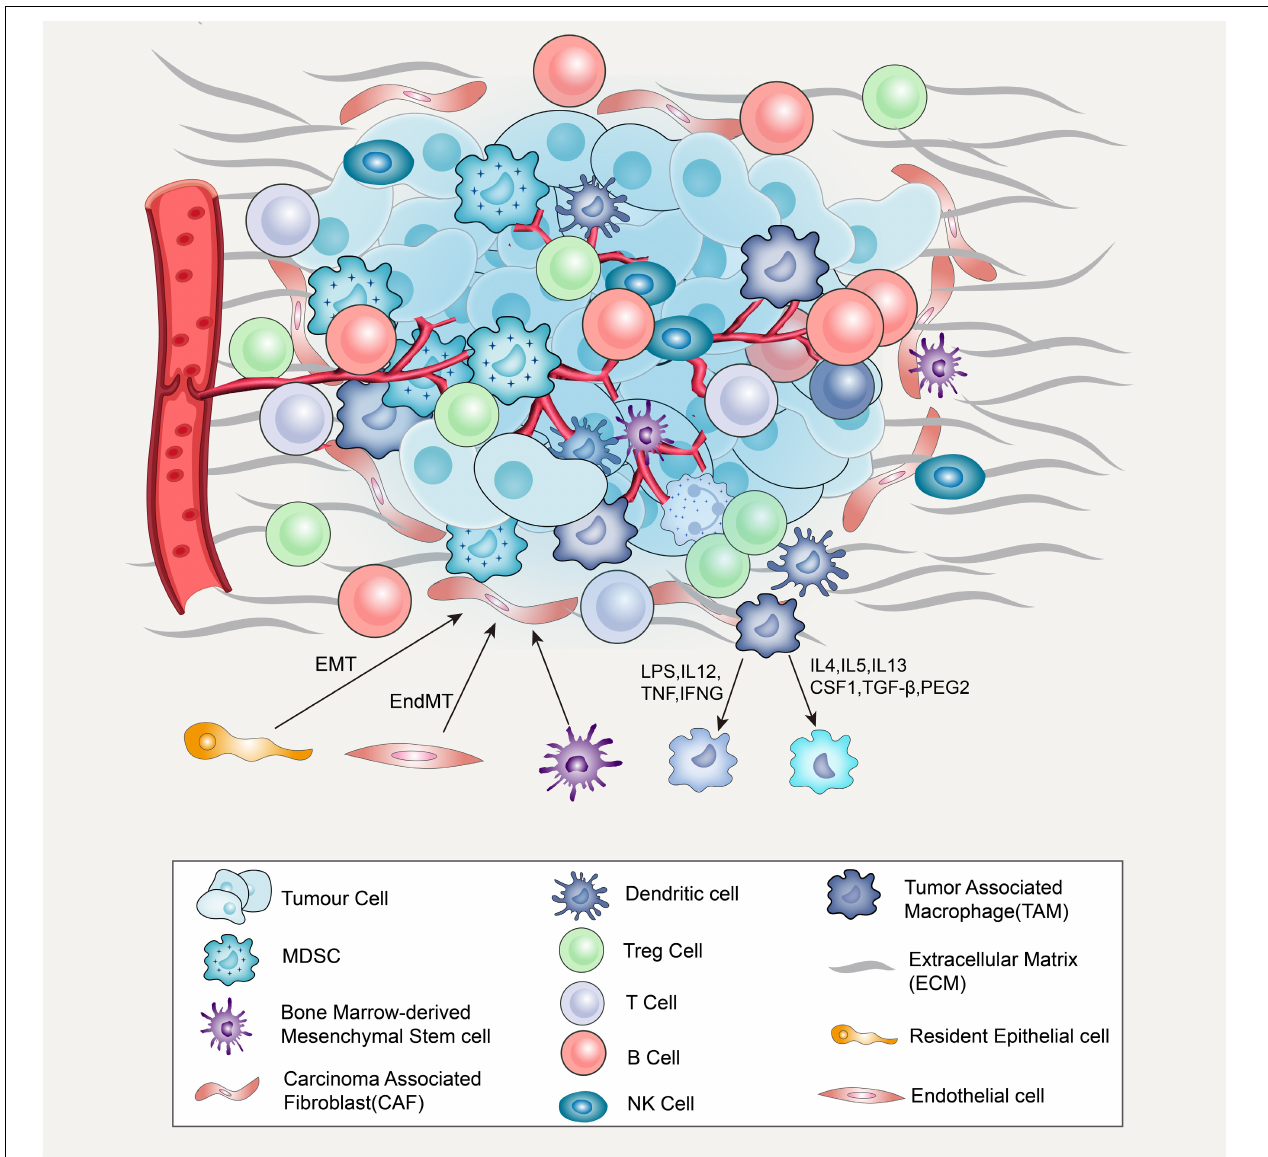
FIGURE 1 | Major cellular constituents and matrix component of the TME, including cancer cells, immune cells (T-cells, B-cells, NK cells, dendritic cells, MDSCs, TAMs), CAFs and ECM. CAF derived from bone marrow mesenchymal stem cells and transform through epithelial–mesenchymal transition (EMT) or endothelial mesenchymal transition (EndMT) from resident epithelium or endothelial cells (A) . When macrophages are exposed to LPS, MAMPs, IL12, TNF, IFNG, or another TLR agonists, they will transition to M1-like. When exposed to IL4, IL5, IL10, IL13, CSF1, TGF β 1, and PGE2, it will transition to M2-like state (B)